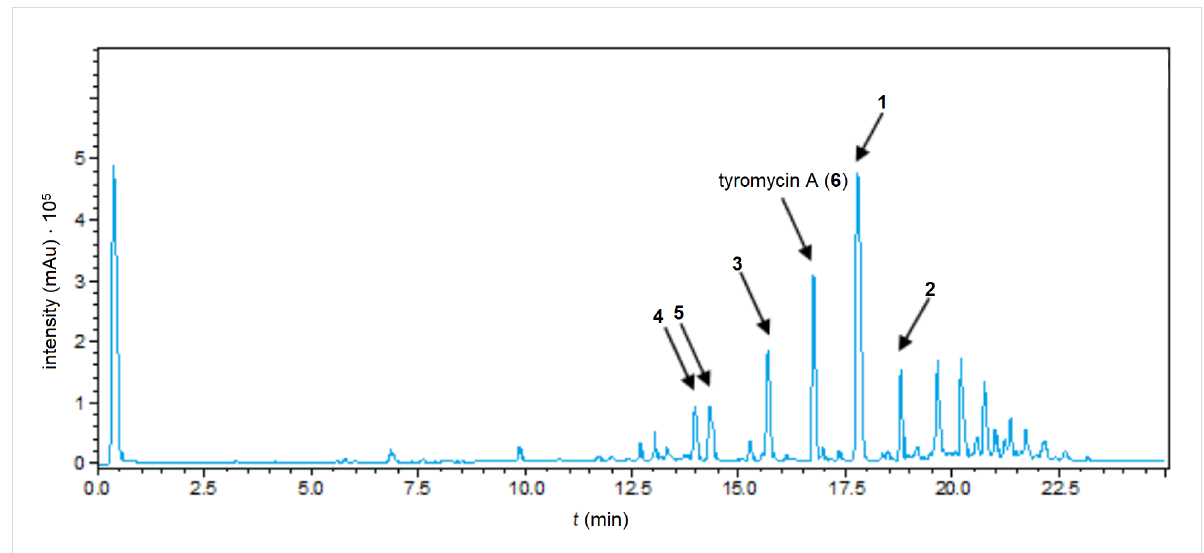
Figure 1: HPLC–UV chromatogram of the extract from fruiting bodies of Skeletocutis sp. (detection wavelength λ = 190–600 nm).